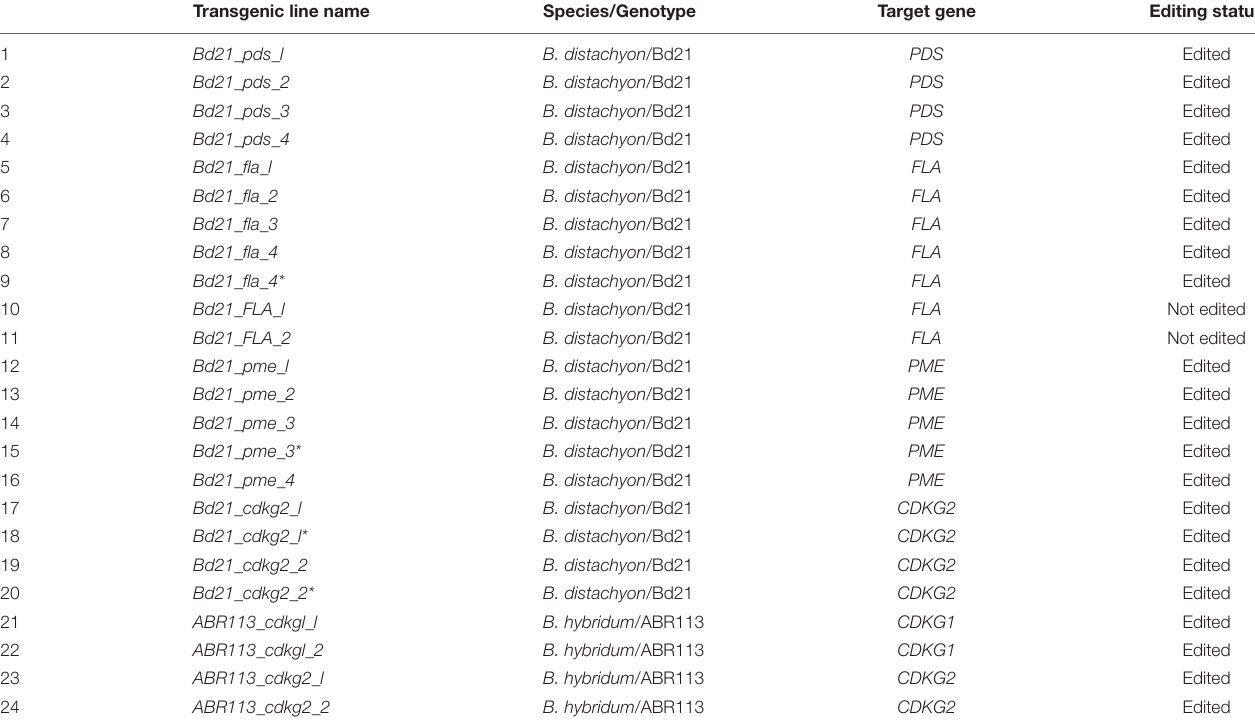
TABLE 1 | List of all obtained transgenic